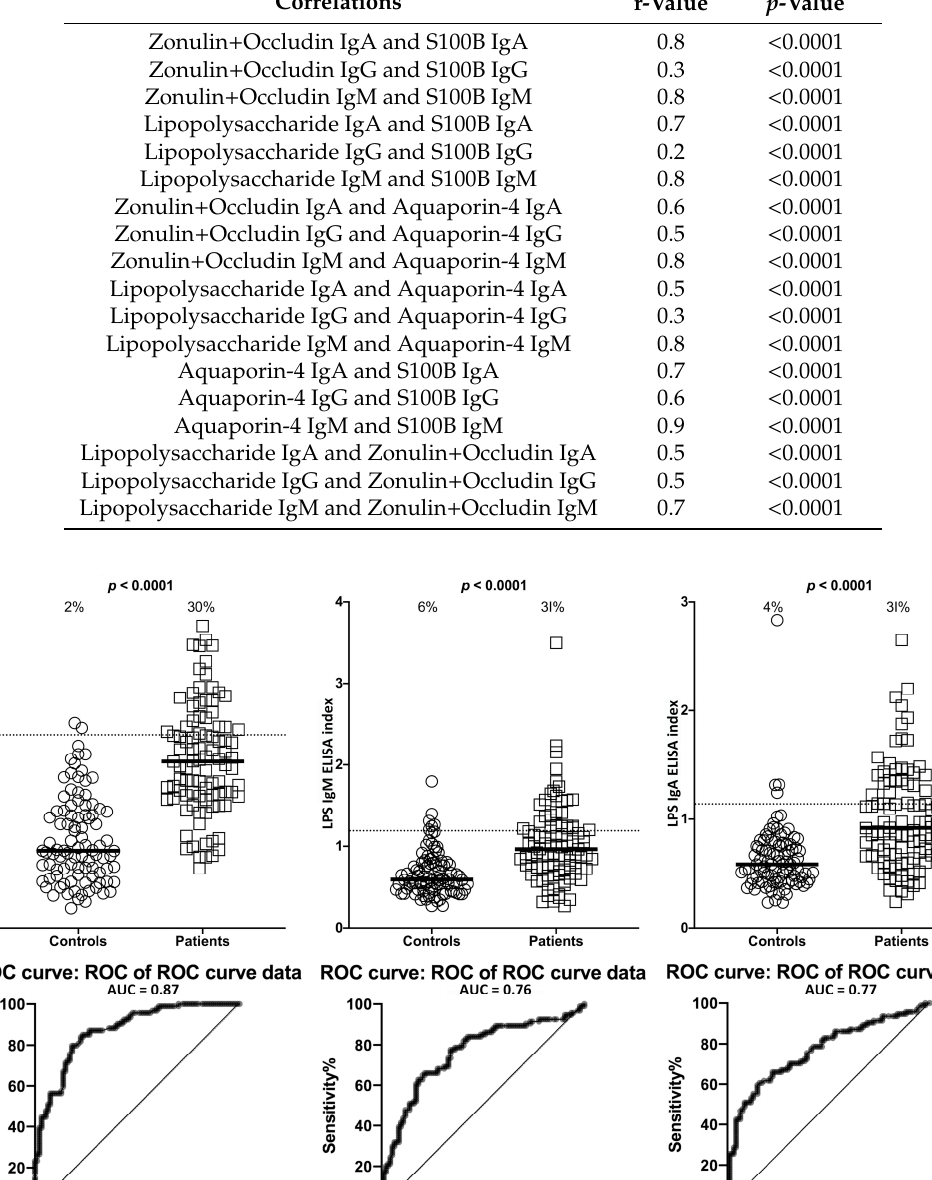
Table 2. Correlation coe ffi cients and p -values for barrier protein antibodies for anti- Saccharomyces cerevisiae antibodies (ASCA) positive subjects.